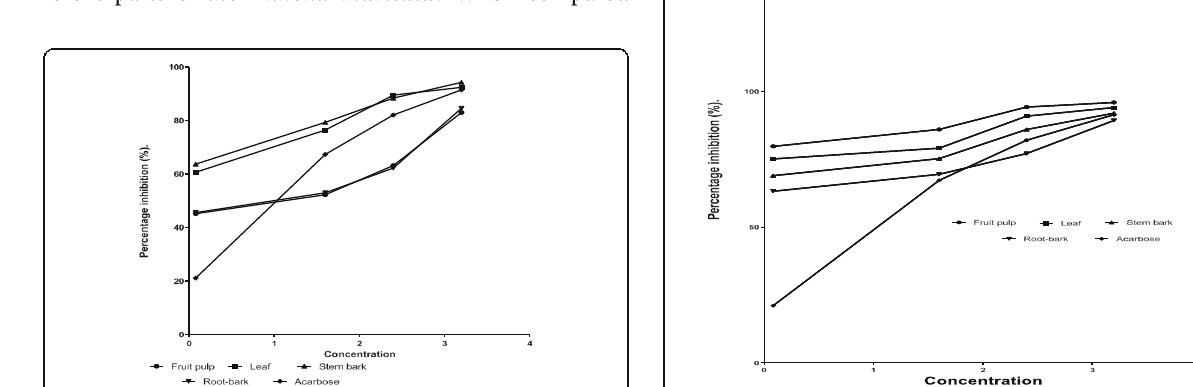
Fig. 12 Percentage inhibition of α -glucosidase by ethyl acetate extract of Annona muricata fruit-pulp, leaf, stem-bark, root-bark and acarbose (reference